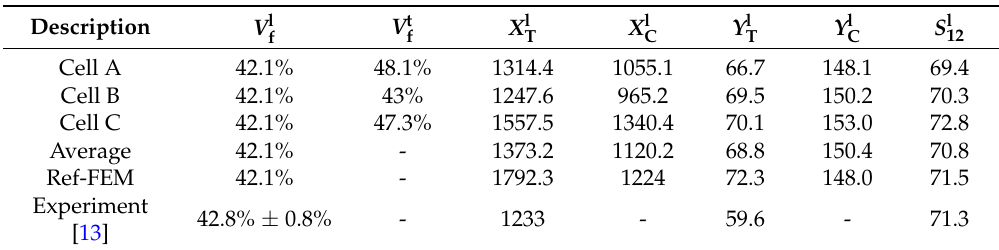
Table 7. In-plane strength of the non-crimp fabric (NCF) lamina evaluated with mesomechanical failure analysis procedure/MPa.